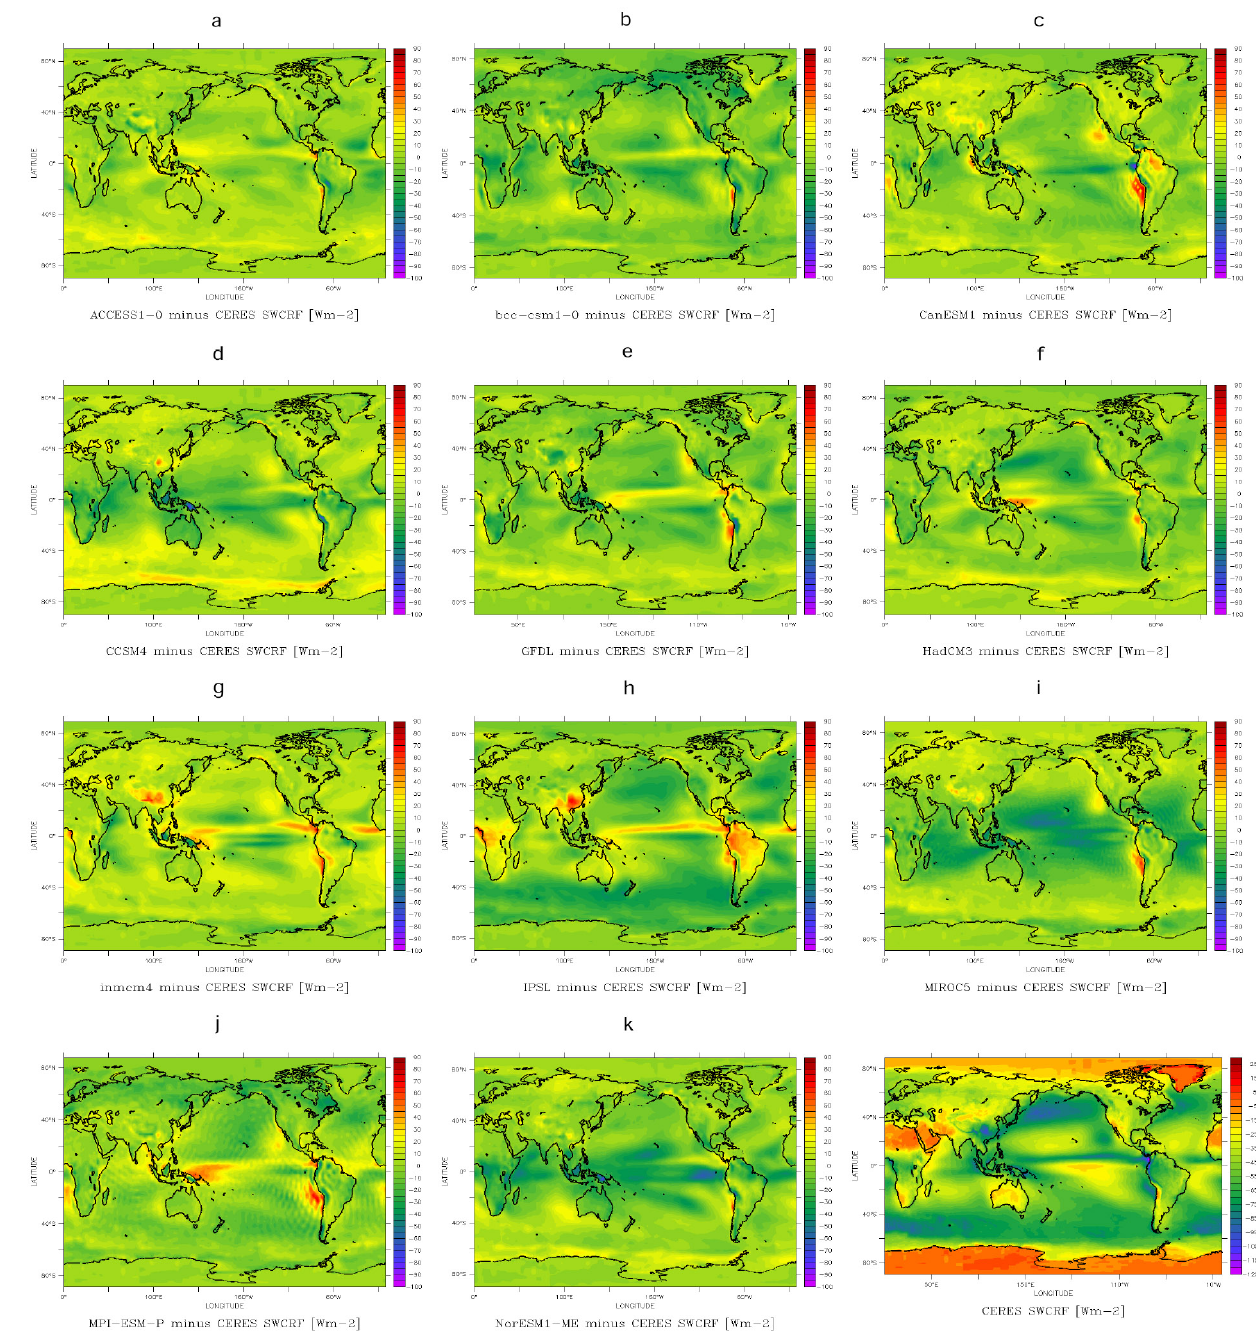
Figure 3. Shortwave cloud radiative forcing (SWCRF) for CERES and several CMIP5 models. Panels (a) to (k) show a map plot for the specific CMIP5 model minus CERES data. In the lowermost right corner is the CERES SWCRF plot. All plots are given in Wm − 2 representing a 10-year mean. The color bar for the CERES SWCRF plot: − 125 up to 25Wm − 2 and for the difference plots: − 100 up to 90Wm − 2